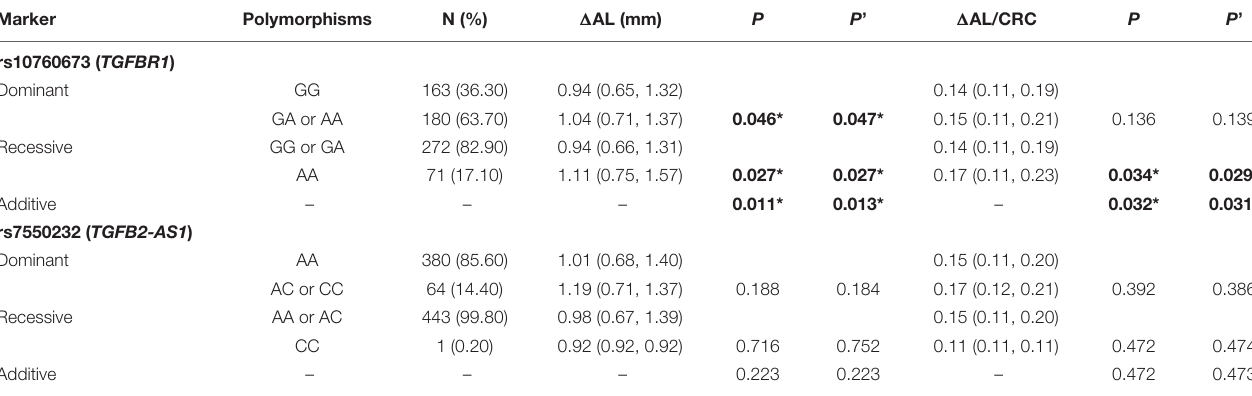
TABLE 5 | Associations between genetic polymorphisms and the changes in ocular biometric parameters in various genetic models. Marker